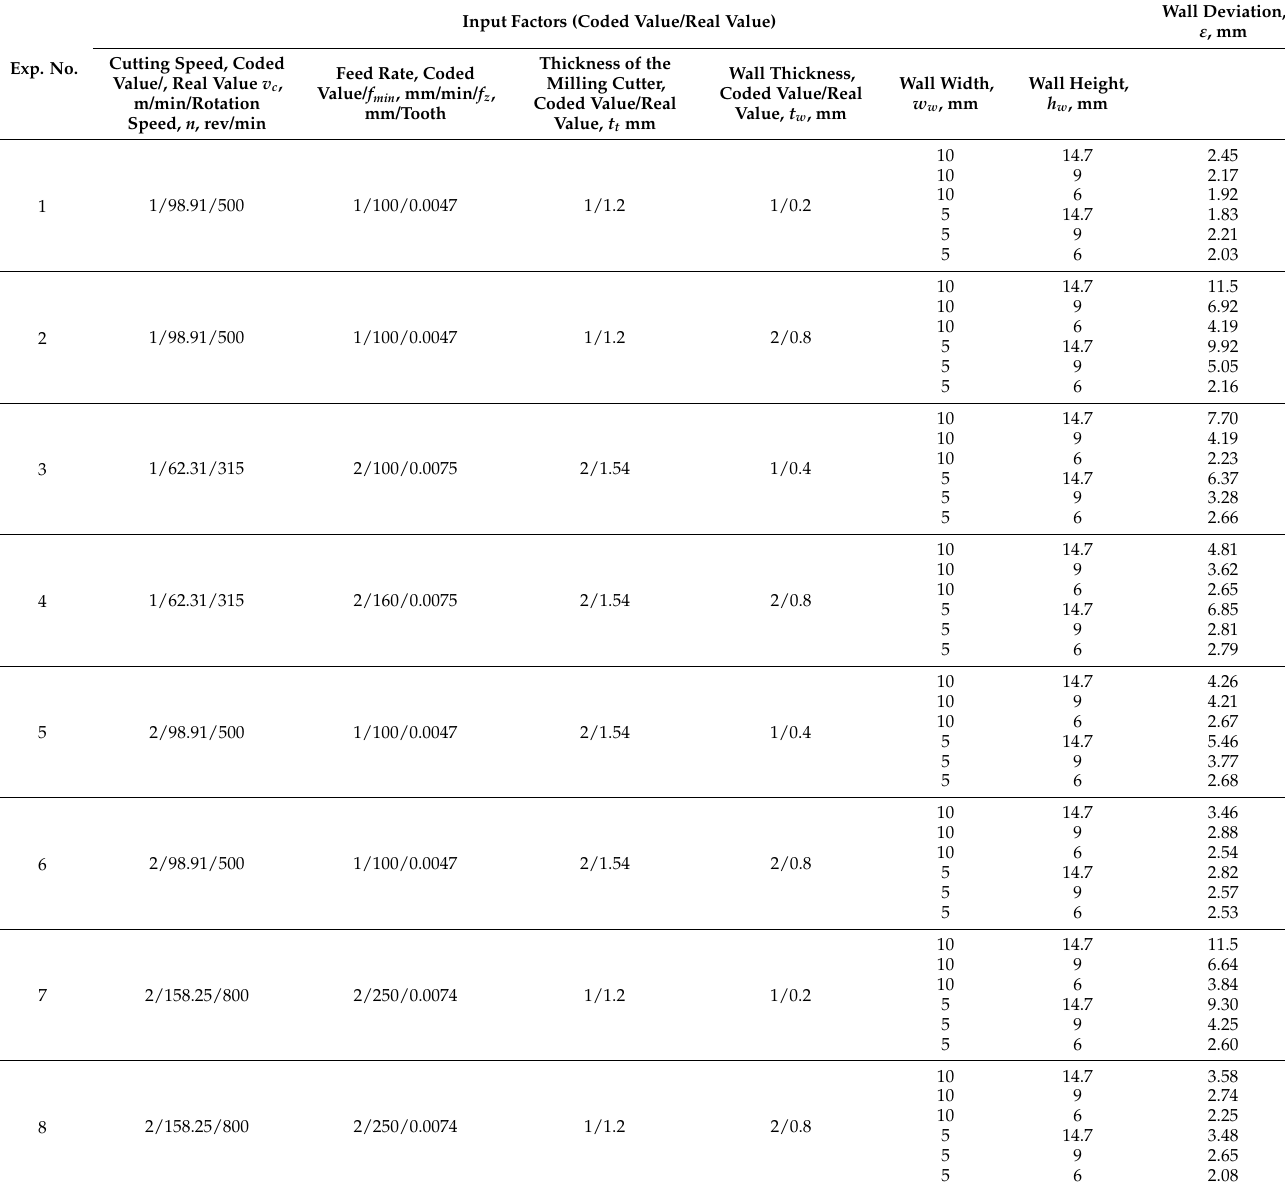
Table 1. Conditions and results of experimental